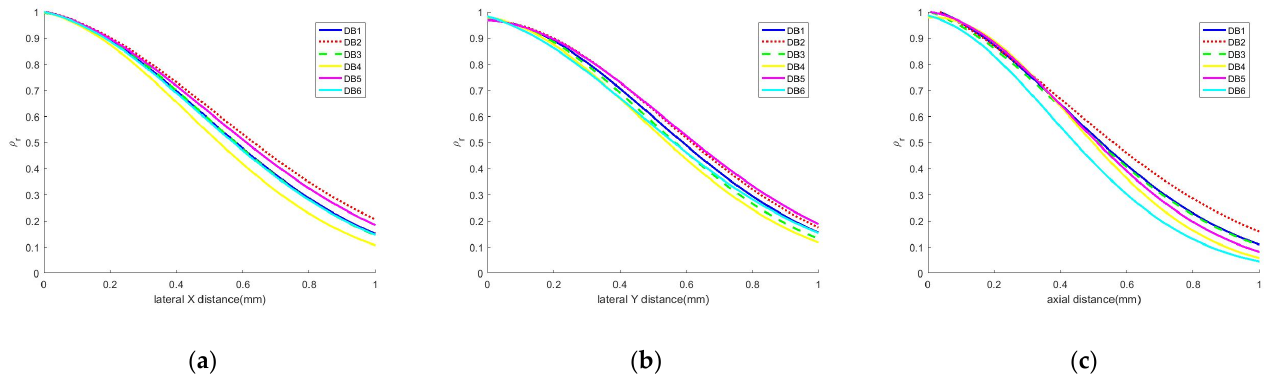
Figure 15. Calibration curve of lateral displacement correlation coefficient. ( a ) X-axis; ( b ) Y-axis; ( c ) calibration curve of axial displacement correlation coefficient.